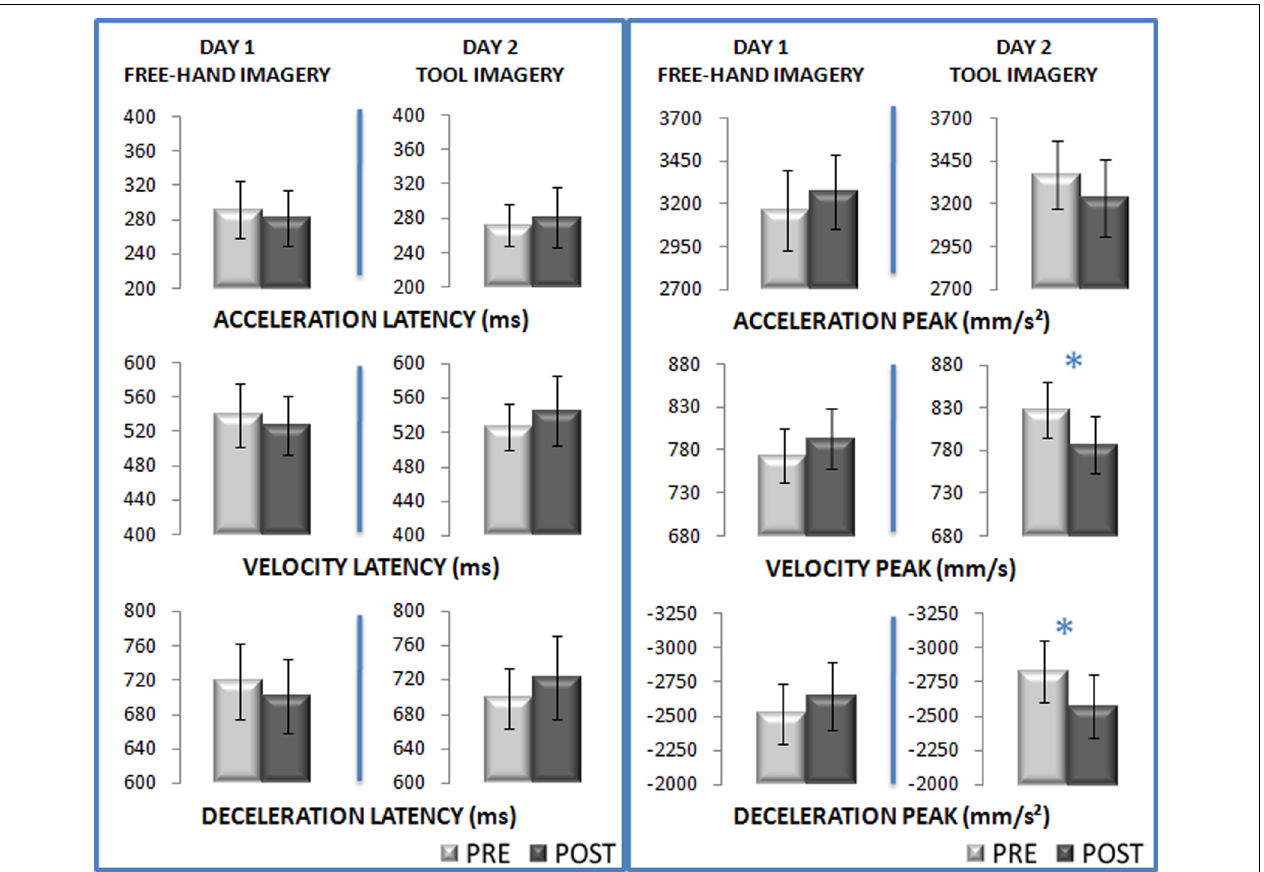
FIGURE 4 | Tool-use imagery modifies free-hand movement kinematics. Bar graphs illustrate mean values for each parameter ± 1 s.e.m. Asterisks denote significant differences from Newman-Keuls post-hoc .